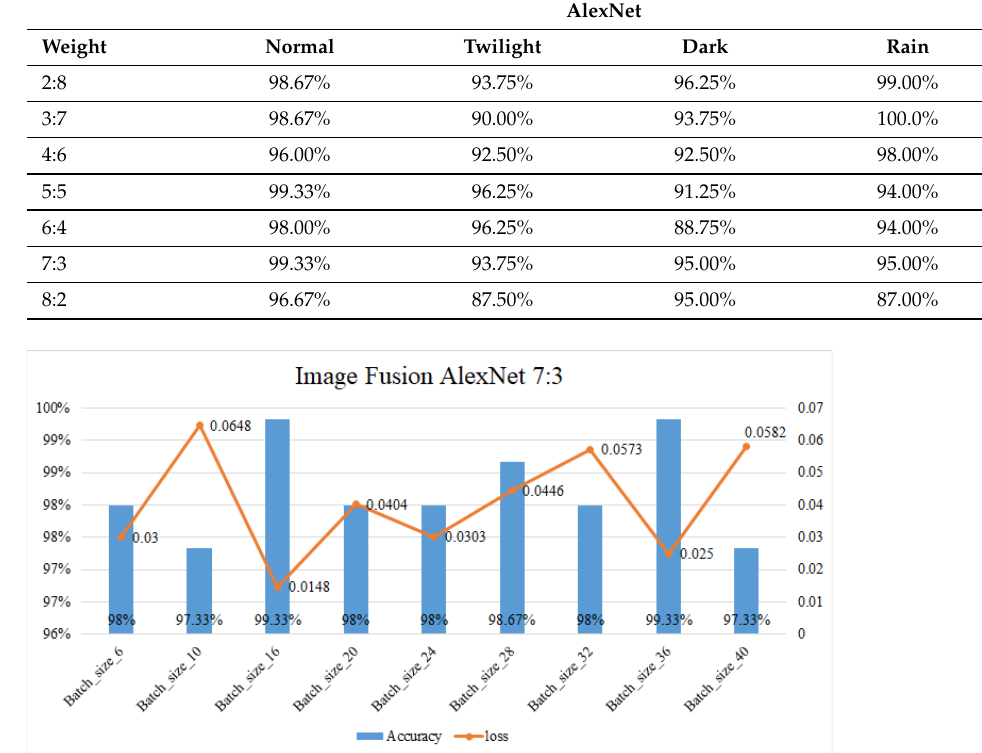
Figure 12. Accuracy and loss ratio when the fusion ration is 7:3 in AlexNet.